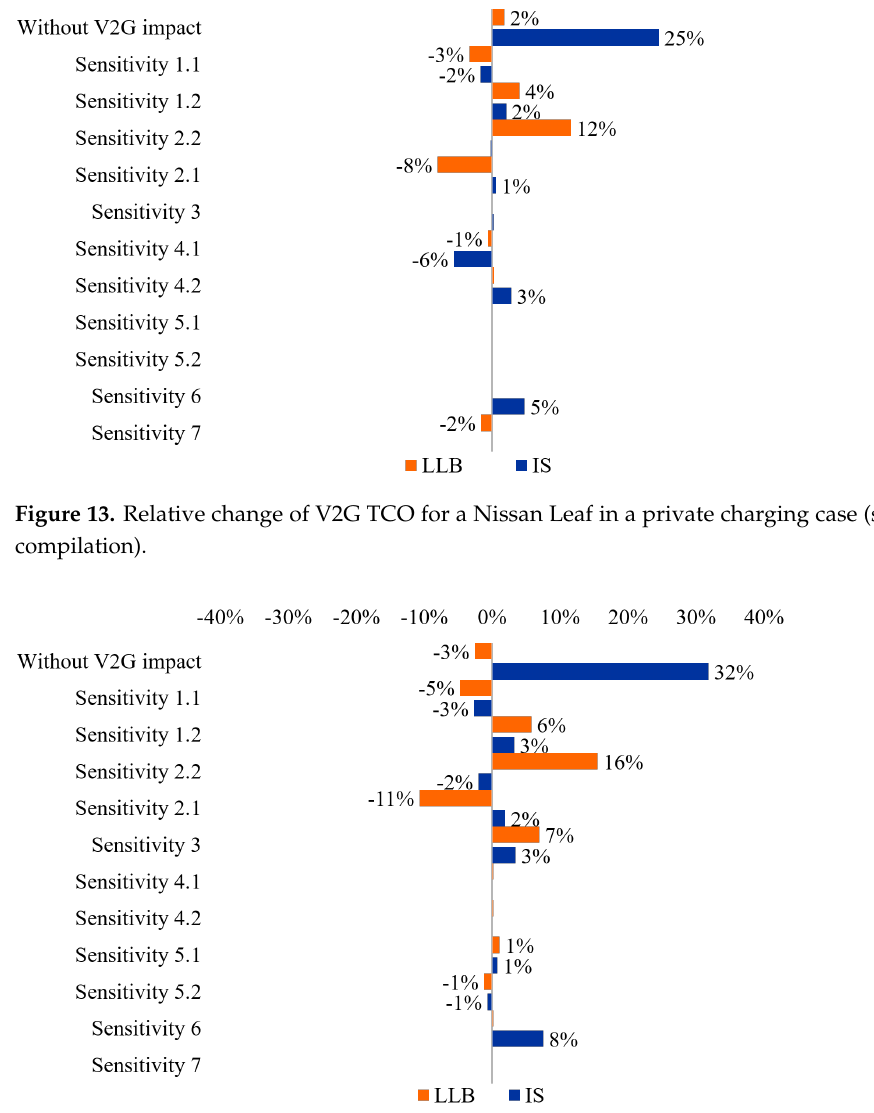
Figure 14. Relative change of V2G TCO for a Nissan Leaf in a semi-public charging case (source: own